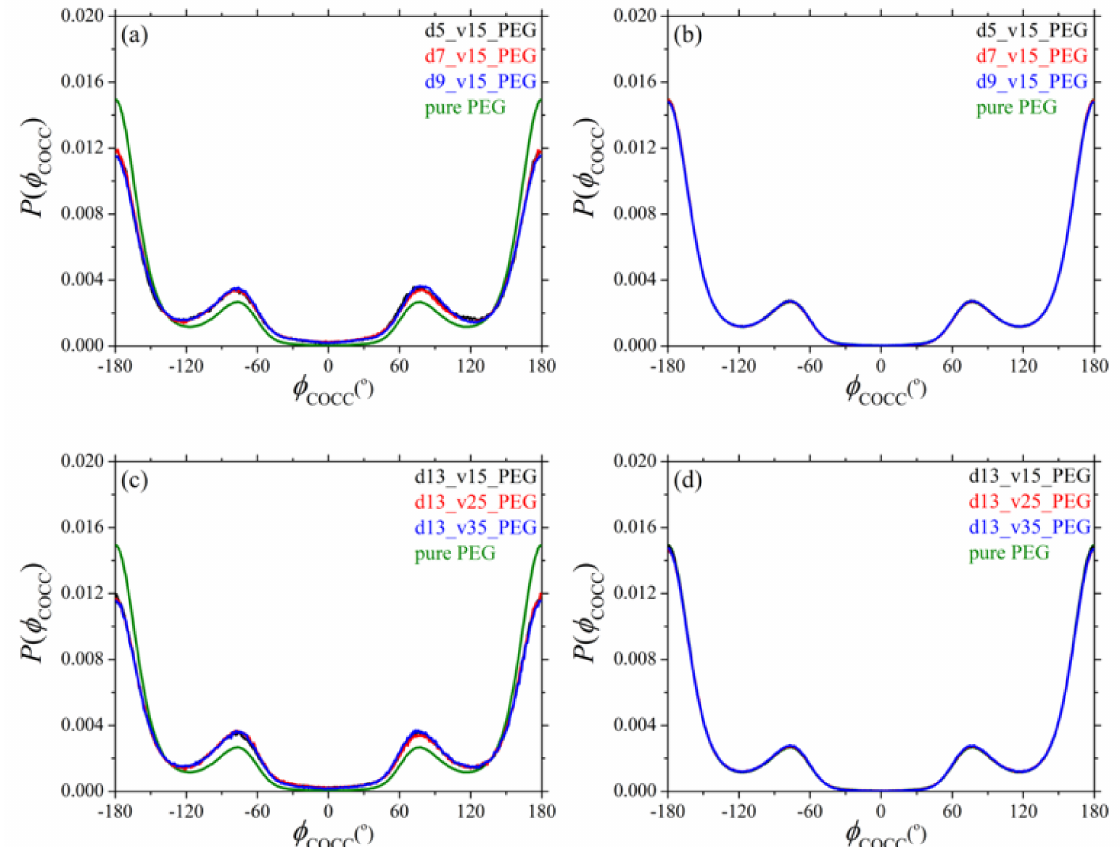
Figure 3. Distribution of the COCC backbone dihedral as obtained from the present npT MD simulations at T = 413 K and p = 1 atm for: ( a ) adsorbed, and ( b ) free chains in systems 2–4 (dependence on nanoparticle size). Parts ( c , d ) show the same distributions but for systems 5–7 (dependence on silica loading). In all cases, the green curve corresponds to the result obtained for the pure PEG melt (system 1) at the same thermodynamic